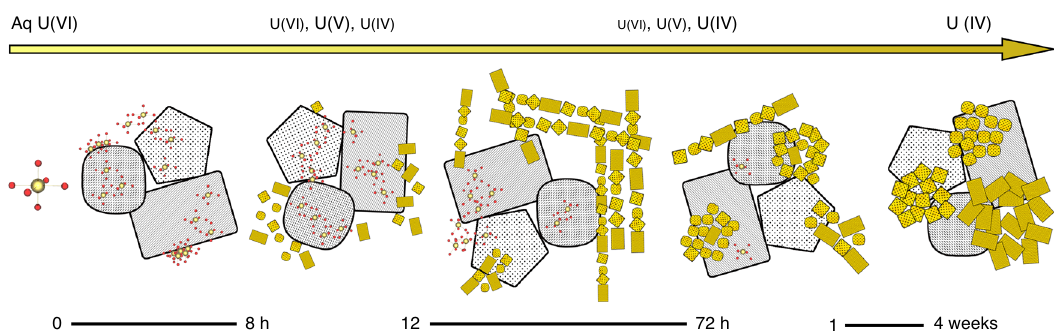
Fig. 8 Conceptual model of U(VI) reduction by magnetite. Magnetite particles are indicated in gray and uranium species in yellow. The reaction starts with rapid adsorption of aqueous U(VI) species onto the magnetite surface. Adsorbed U(VI) is reduced to U(V) and U(IV) species. While U(V) remains on the magnetite surface, U(IV) precipitates out as uraninite nanoparticles that self-assemble into nanowires structures anchored to the magnetite surface. Nanowires continue to grow while reduction proceeds. Eventually, crystal growth and coalescence lead to the collapse of nanowires into UO 2 nanoclusters in which nanoparticles display a preferred